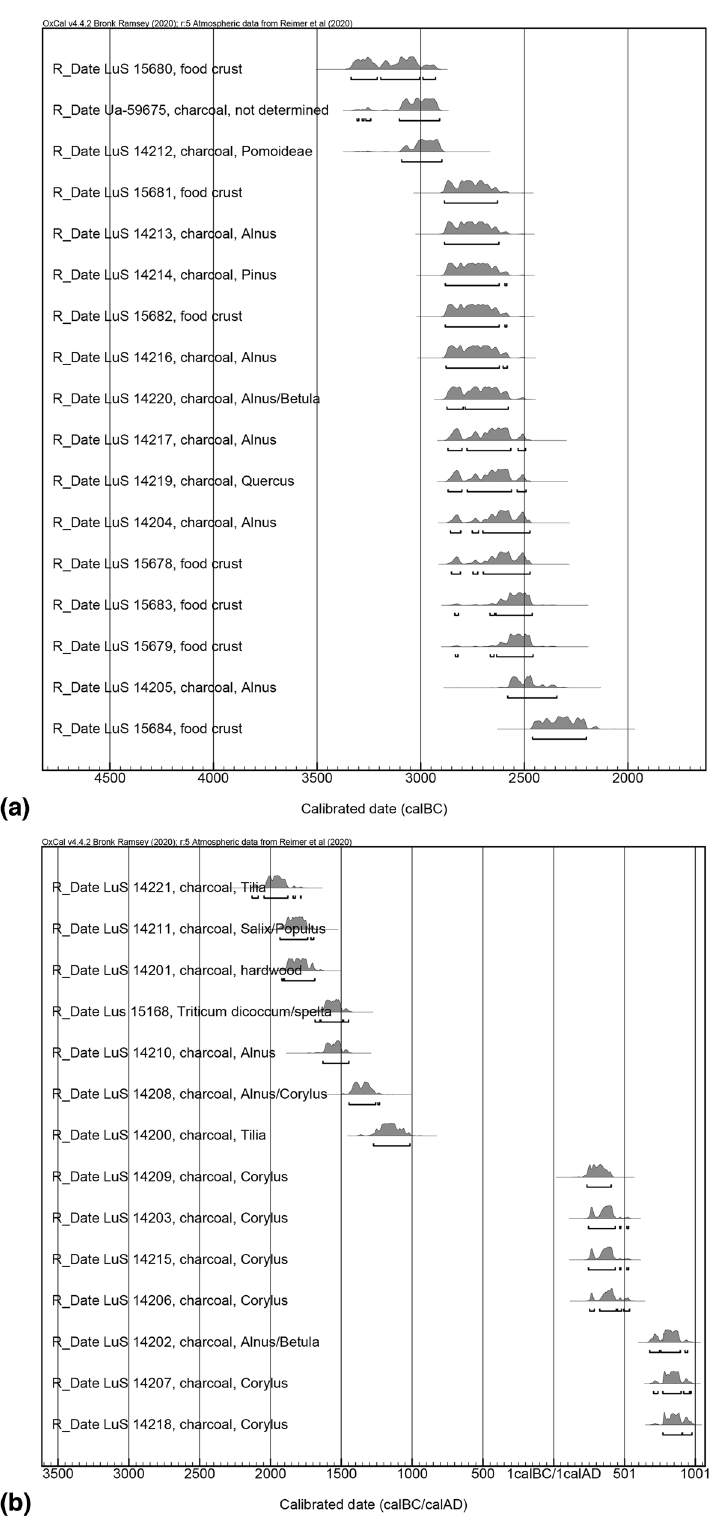
Figure 4: ( a and b ) Radiocarbon dates from the Alveberget site. From a total of 31 C14 dates, 17 falls within the period 3350 – 2200 cal. BCE. The remaining dates are linked to forest activity in the Bronze Age and Iron Age. LuS, analyzed at the Radiocarbon Dating Laboratory, Department of Geology, Lund University ( Nielsen & Rundgren, 2019a, 2019b, 2020 ) . Ua, analyzed at Ångströmlaboratoriet, Uppsala University ( Possnert & Balkefors ( 2018 ) . Calibrations performed using OxCal v4.4.2 Bronk Ramsey ( 2020 ) ; r:5, atmospheric data from Reimer et al. ( 2020 )